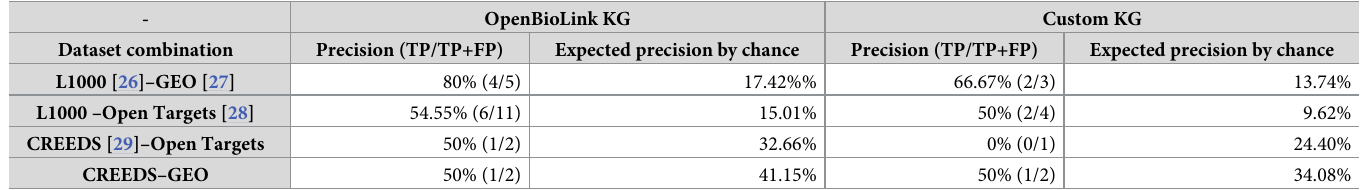
Table 1. Evaluation of RPath in multiple datasets across the two KGs using precision. Each row corresponds to the results of running RPath on a specific drug-disease dataset combination. The second and fourth columns show the performance that is expected to be achieved by chance. - OpenBioLink KG Custom KG Dataset